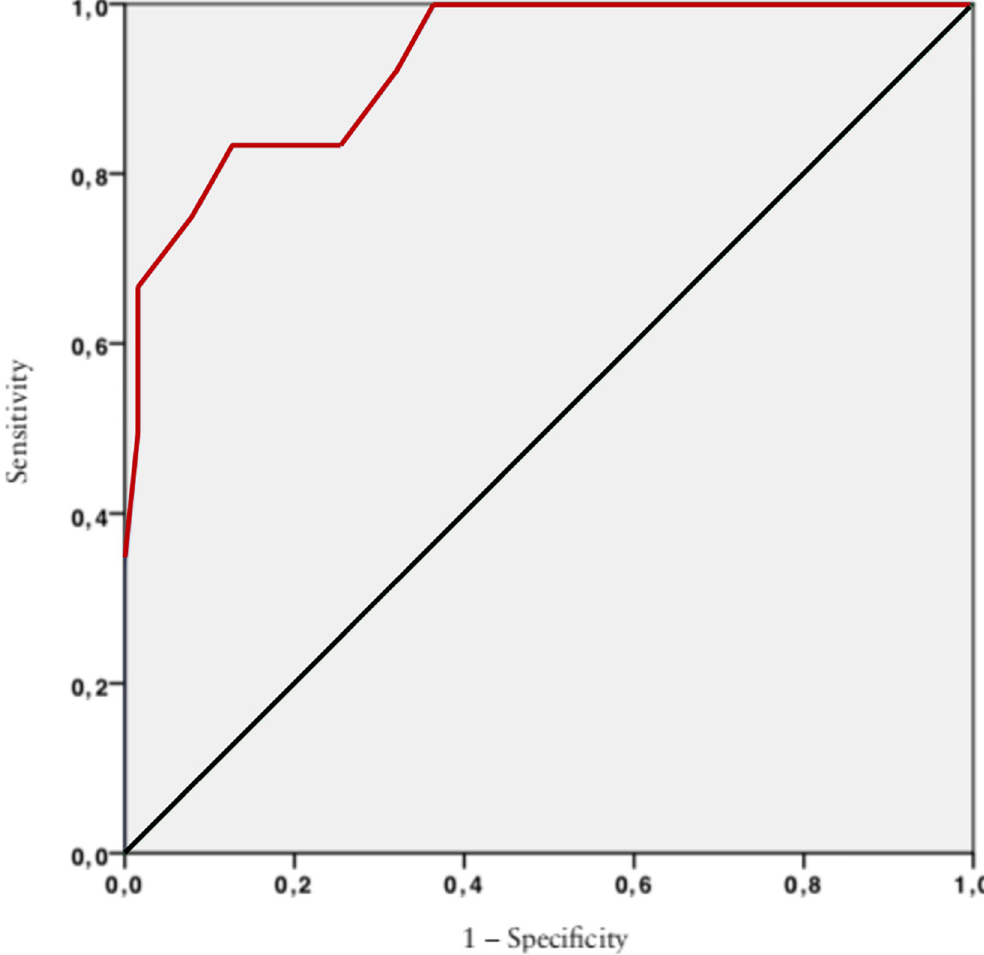
Fig 2. Prediction of neonatal outcome: Performance of bladder diameter in the prediction of favorable or adverse outcome of megacystis in the first trimester.